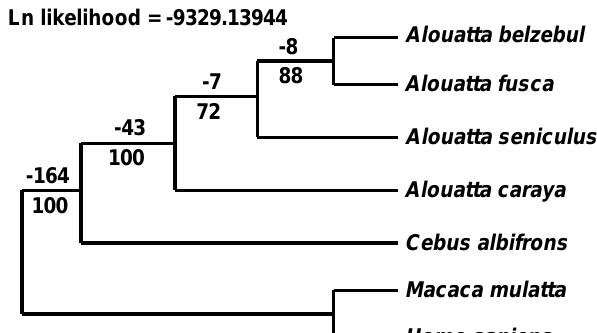
Figure 5 - Maximum likelihood tree derived from the aligned g 1 -globin nucle- otide sequences in seven simian species. Log likelihood is -9329.13944. Values above the lines represent the minimum decrease in the log likelihood required to break up the clade designated by that node and those below the lines, the percentage of bootstrap values obtained in 2,000 replicates.